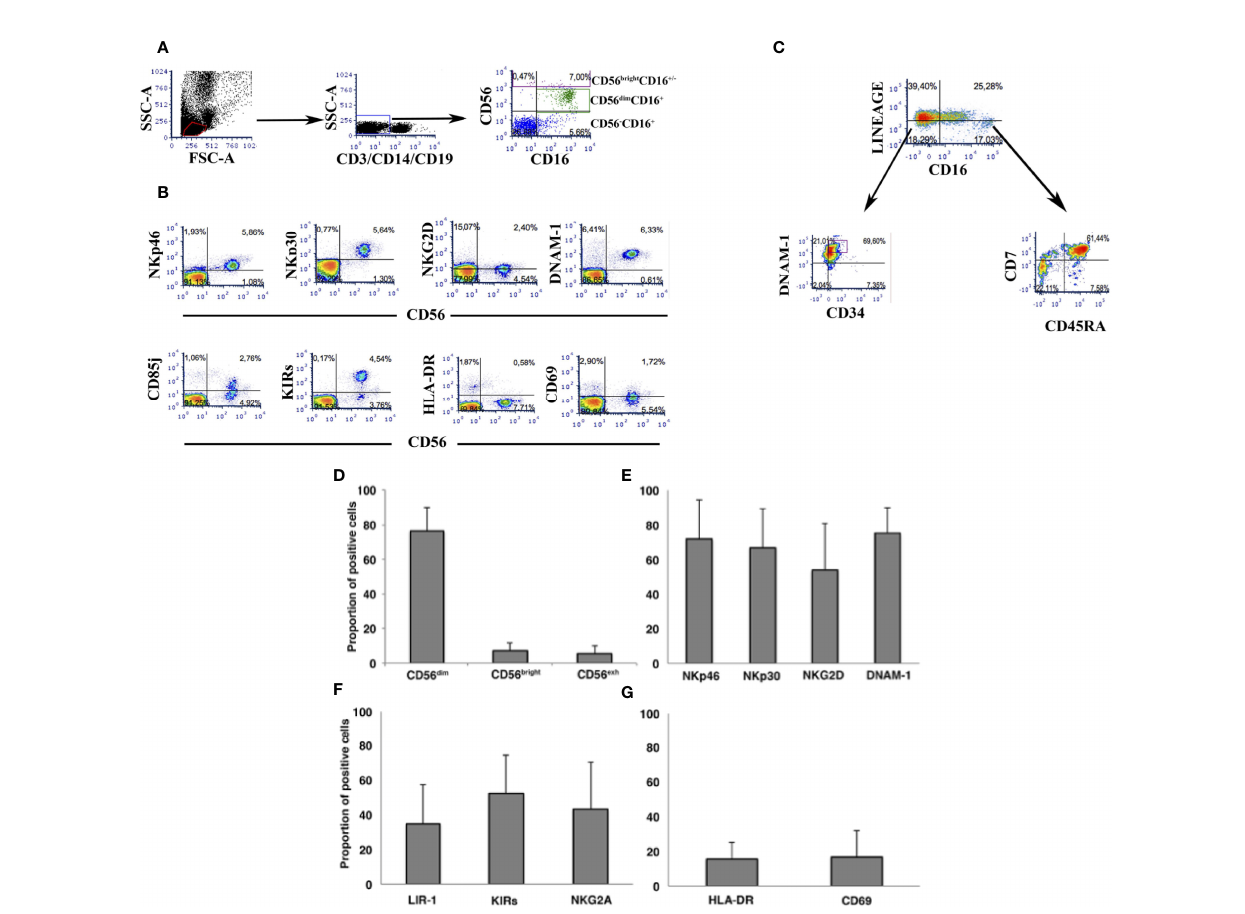
FIGURE 3 | Flow cytometric analysis of peripheral NK cells in the cohort of PHIV. (A) Flowcytometric analysis of PBMC in a representative patient. Dot plots show gating strategy of PBMC to assess NK cell frequency. (B) Flowcytometric analysis of NK cells in a representative patient. CD3-14-19-56+ cells are stained for different NK cell surface antigens using directly labelled speci fi c mAbs. (C) Flowcytometric analysis of a representative patient showing gating strategy and labelling to assess the frequency of (CD3-14-19-56-) and of CD34+CDNAM-1bright in fl ammatory cell precursors and of (CD3-14-19-56-). “ Lineage ” labels cells as lineage positive (CD3+14+19+56+) and lineage negative (CD3-14-19-56-)for gating and analysis of in fl ammatory precursors. (D-G) Histograms indicate mean ± SD of NK cells in PBMC of patients at the time of HIV reservoir determination. Frequencies are shown for the three major circulating NK cell subsets (D) , for NK cells expressing activating receptors (E) , inhibitory NK cell receptors (F) , and activation molecules (G) .